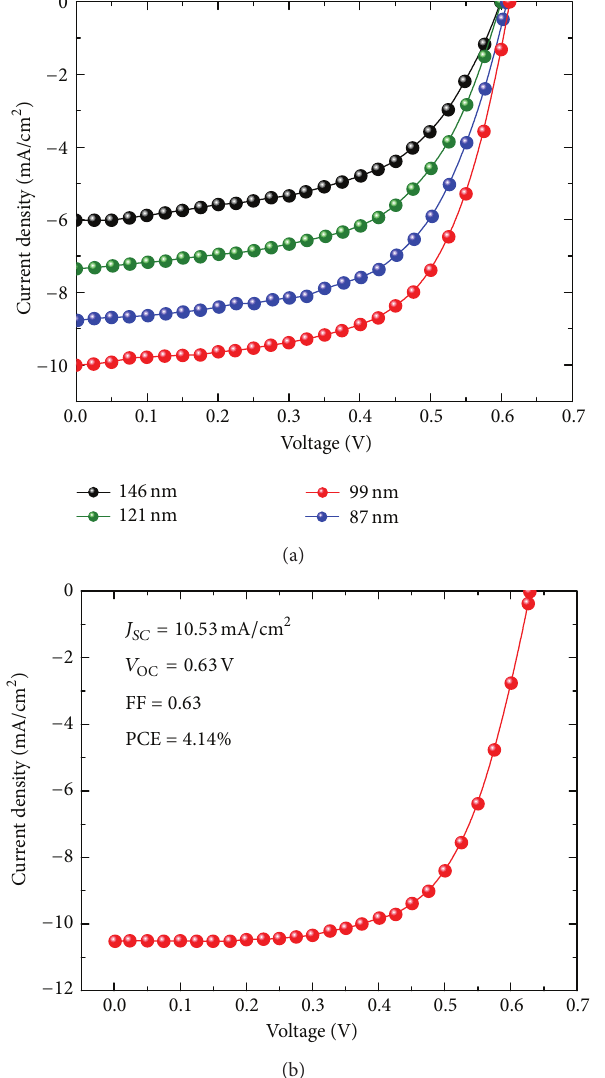
Figure 1: (a) J - V characteristics of P3HT :PC 61 BM OPCs fabri- cated at different thicknesses of the active layer and (b) the best P3HT: PC 61 BM OPC with active layer thickness of 100 nm.